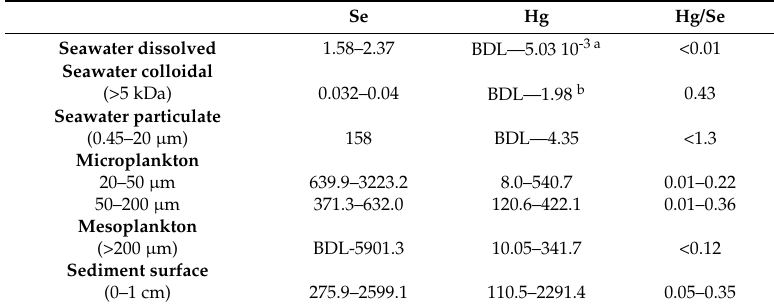
Table 2. Summary of Se ( µ g/kg) and Hg ( µ g/kg) concentrations and Hg/Se (molar) ratios in the water column and surface sediments of the Gulf of